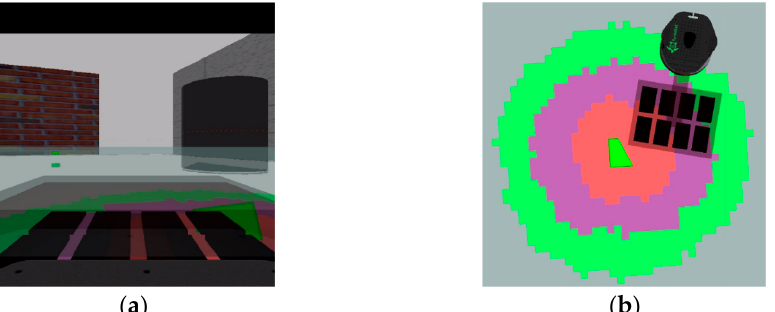
Figure 11. Real-time radiation-detection results in simulation: ( a ) camera view and ( b ) local radiation map.